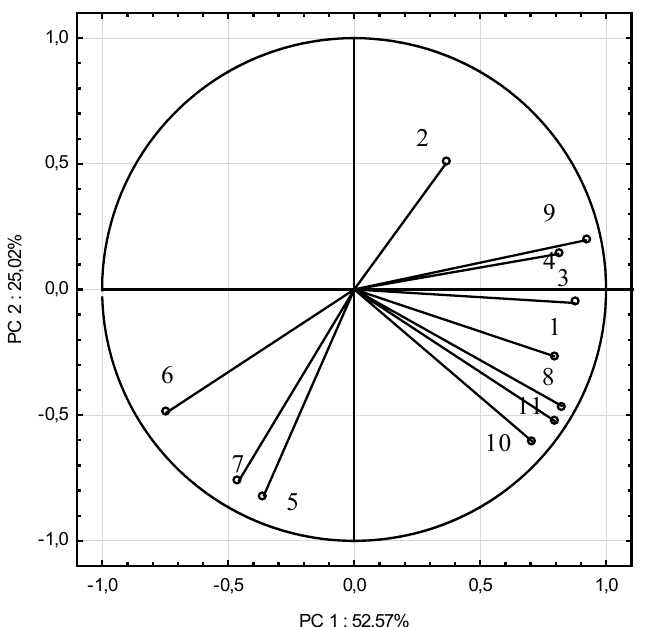
Figure 2 : Dependences observed on control object without seeds inoculation.